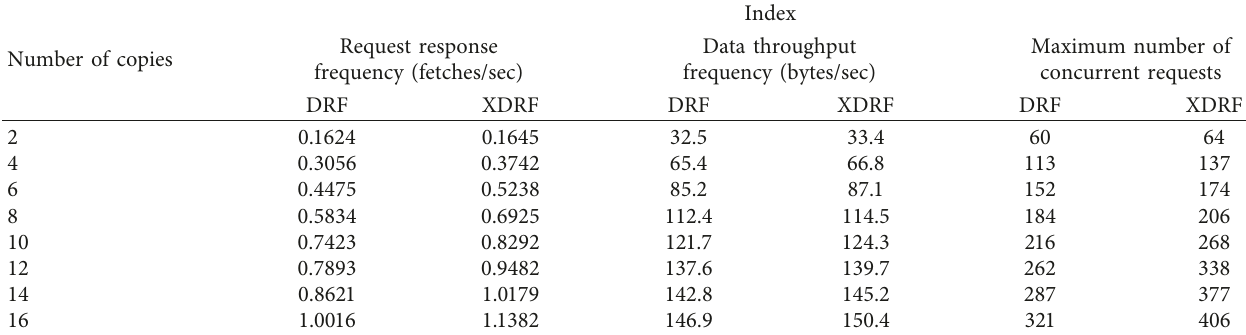
Table 2: Comparison of pressure test results before and after replica expansion.